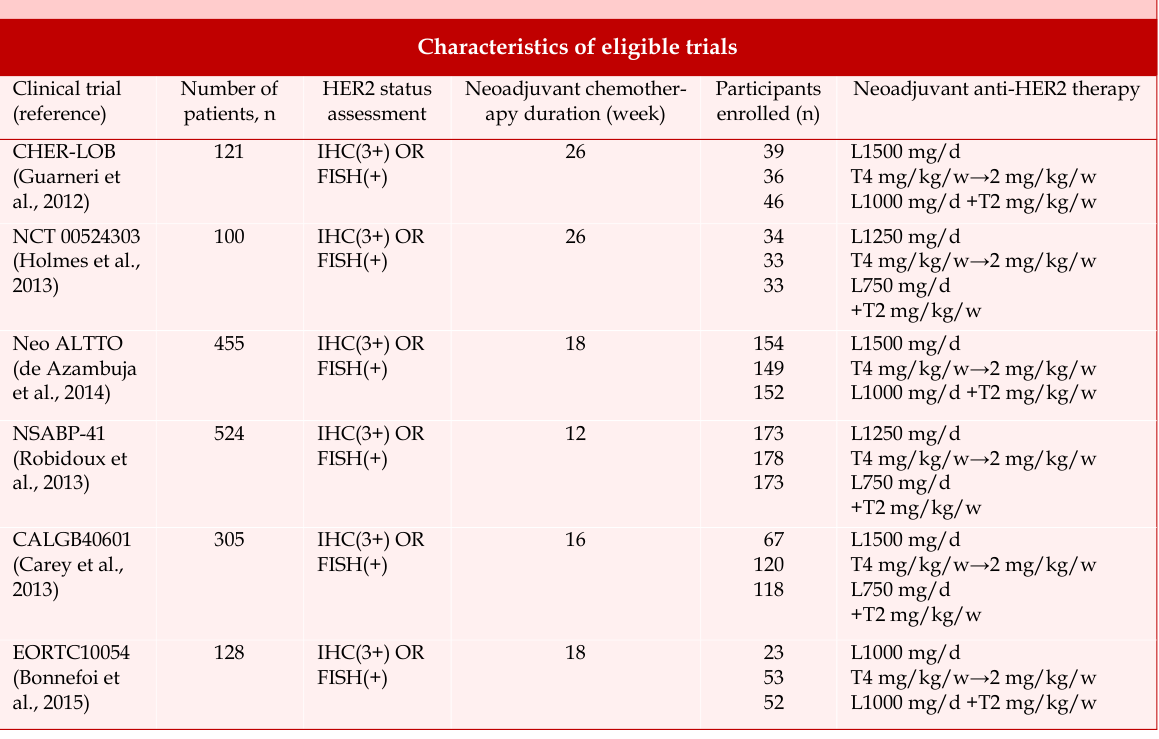
Characteristics of eligible